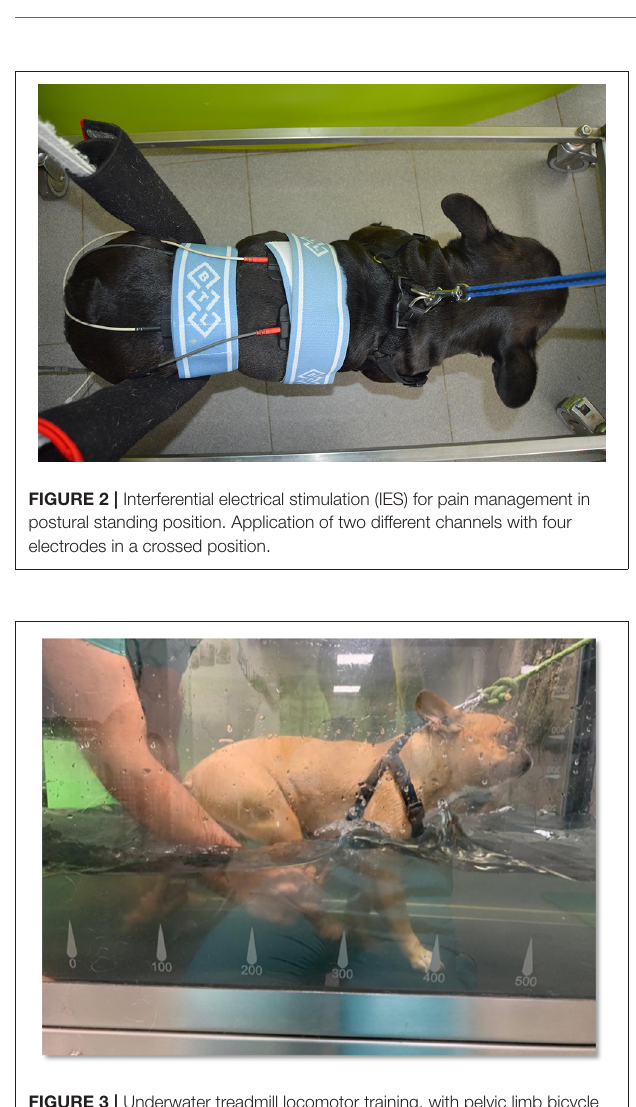
FIGURE 3 | Underwater treadmill locomotor training, with pelvic limb bicycle movements performed by the technician.